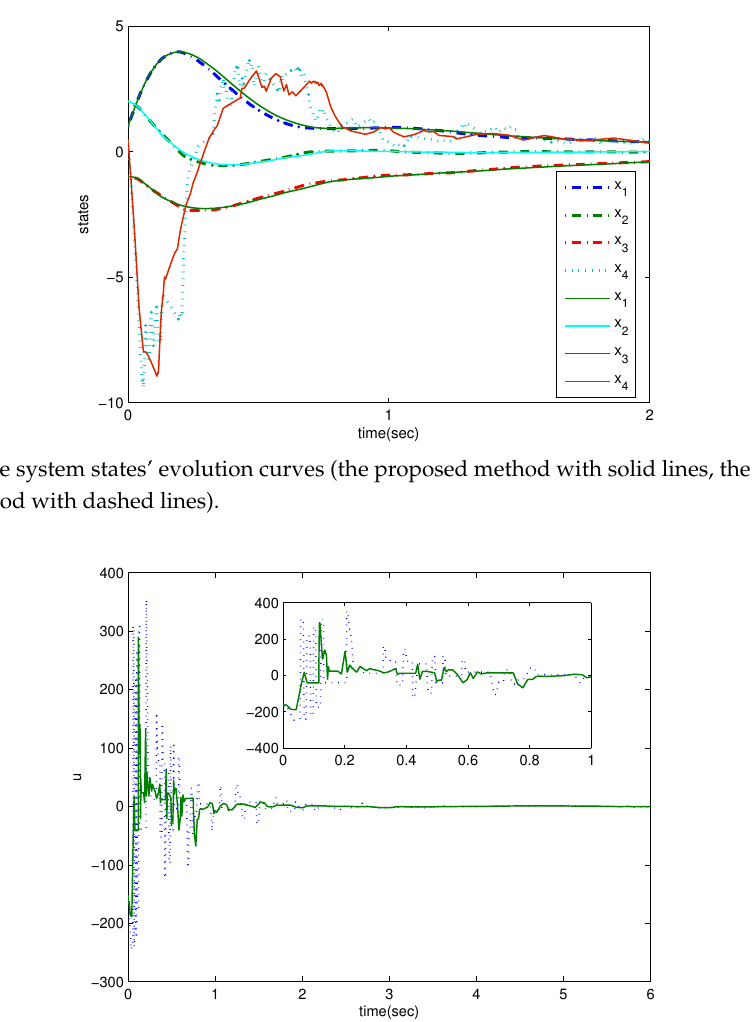
Figure 2. The system states’ evolution curves (the proposed method with solid lines, the memoryless design method with dashed lines).